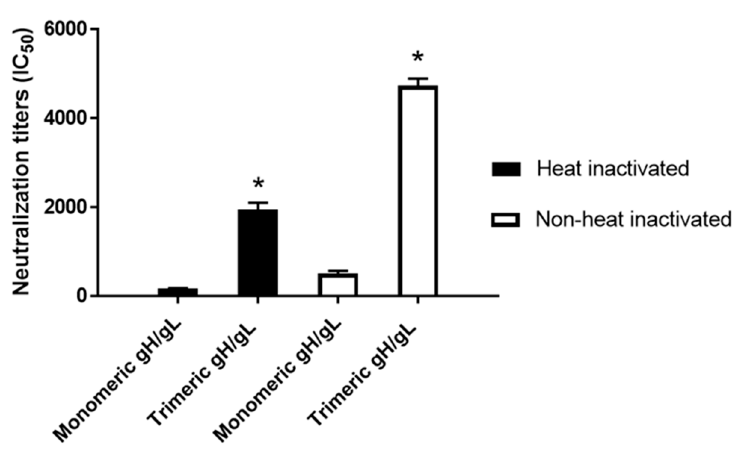
Figure 4. Immunization with HCMV trimeric gH / gL elicited significantly higher serum titers of complement-dependent and complement-independent HCMV-neutralizing activity for epithelial cells compared to monomeric gH / gL. Day 52 pooled sera from five rabbits immunized with 25 µ g of HCMV trimeric versus monomeric gH / gL recombinant protein were heat-inactivated (closed bar) or non-heated (open bar), and IC50 neutralizing activity was determined of each pooled sample in quadruplicate using the ARPE-19 epithelial cell line and HCMV strain AD169 wt131 . Significance * p < 0.05 compared to the sera from rabbits immunized with HCMV monomeric gH / gL.